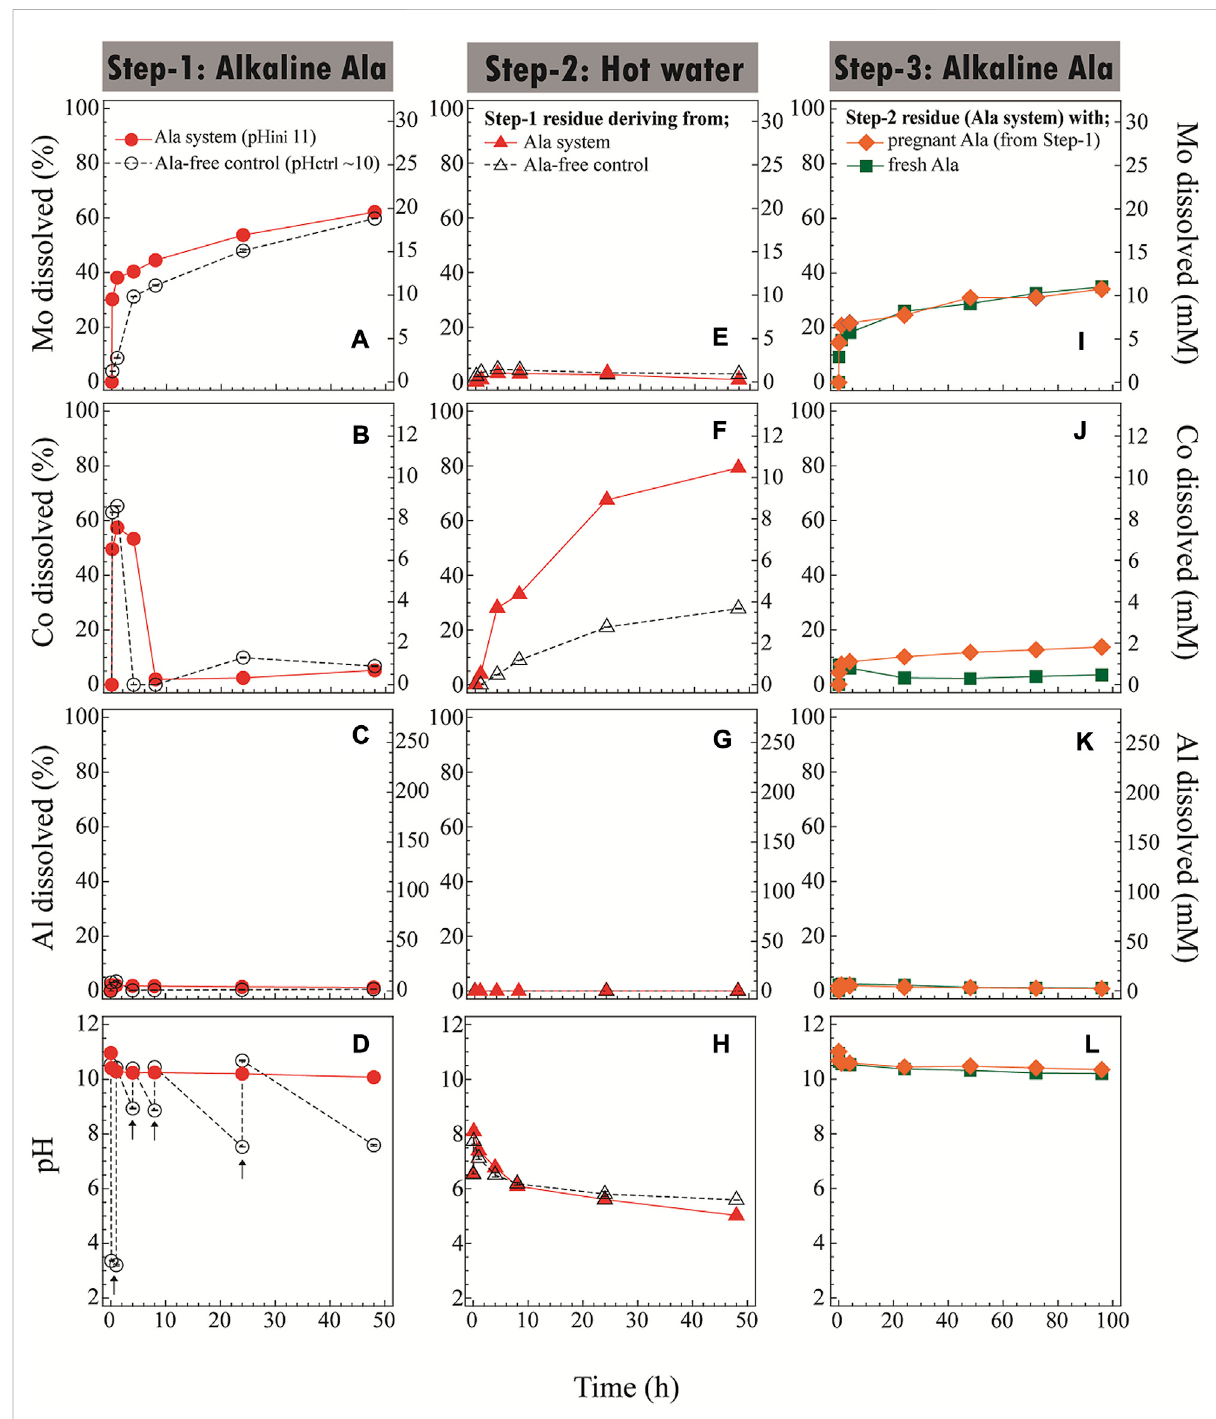
FIGURE 3 Sequential3-stepleachingofspentcatalyst.Step-1 (A – D) :AlkalineAlaleaching(pHini11; C )orAla-freecontrol[pHadjustedto~10withNaOH, as indicated by arrows (D) ; ○ ] at 45 ° C. Step-2 (E – H) : Hot water leaching of the Step-1 solid residue [deriving from Ala system ( ▲ ) or Ala-free control ( △ )] at 70 ° C, pHnatutal. Step-3 (I – L) : Second alkaline Ala leaching of the Step-2 solid residue (deriving from Ala system in Step-1), either by reusing pregnant Ala solution from Step-1 (re-adjusted to pHini 11; ) or by using fresh Ala solution (pHini 11; ) at 45 ° C. The dissolution pro fi le of Mo (A,E,I) , Co (B,F,J) , and Al (C,G,K) as well as the pH pro fi le (D,H,L) are